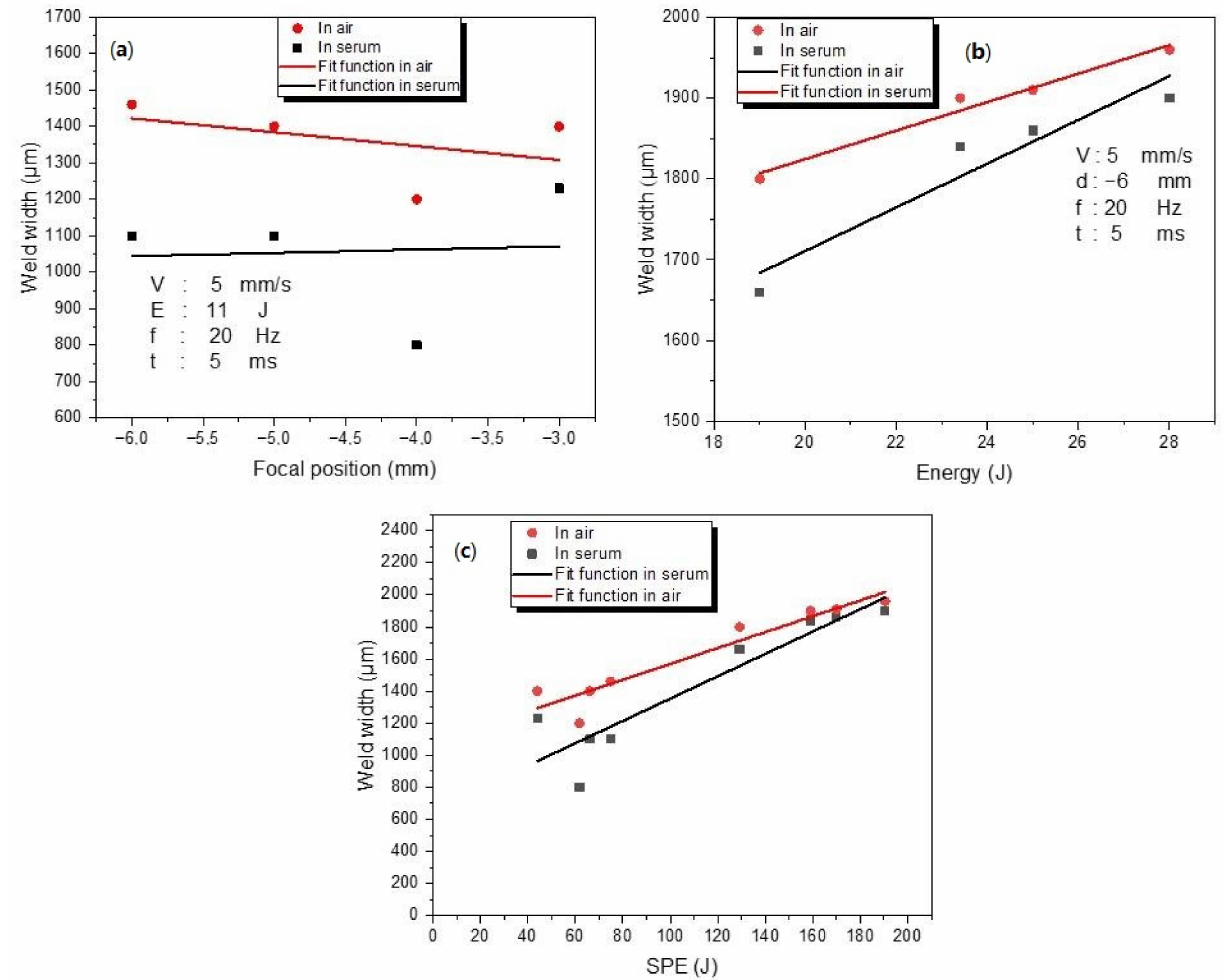
Figure 12. The variations in the weld width ( µ m) with focal position ( a ) , energy ( b ), and SPE ( c